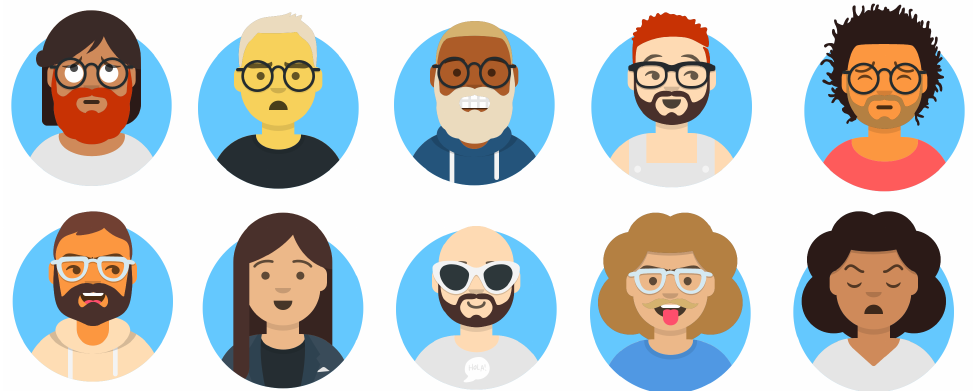
Figure 3. List of possible avatars that can be created with module Avatars.